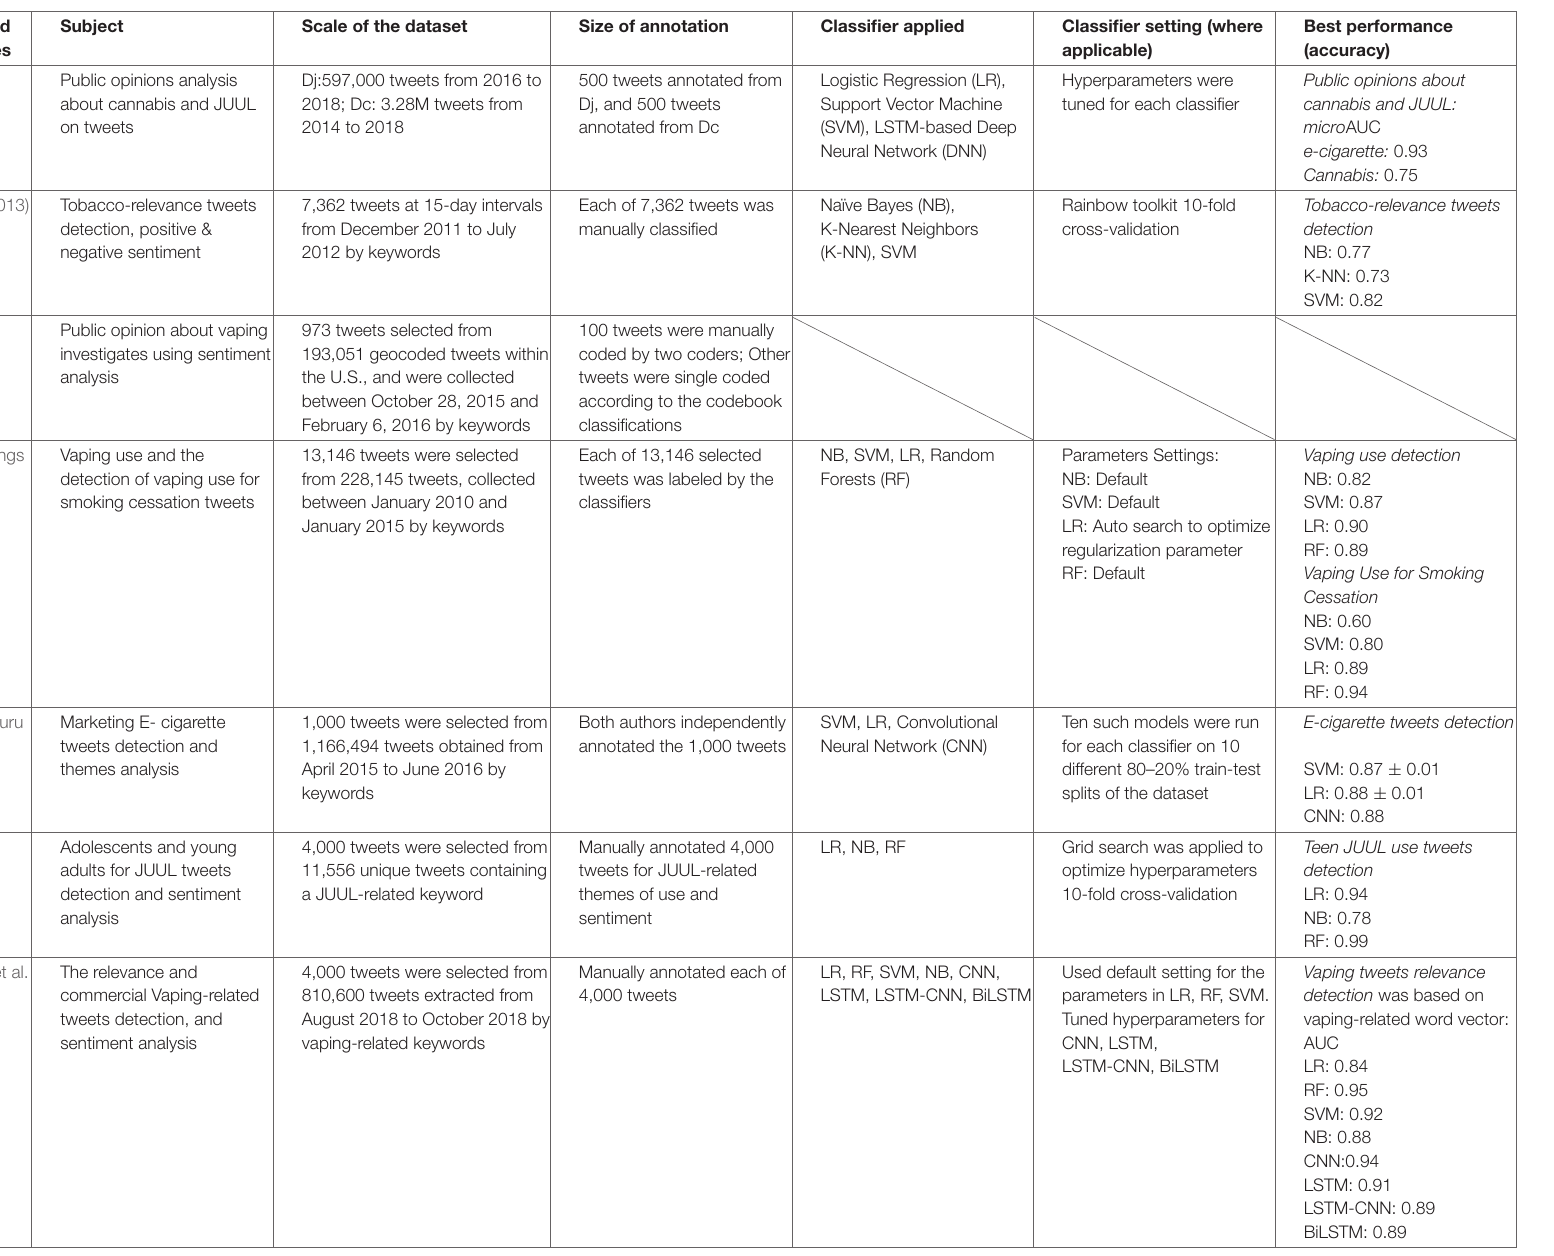
TABLE 1 | Summary and cross-comparison of vaping-related twitter